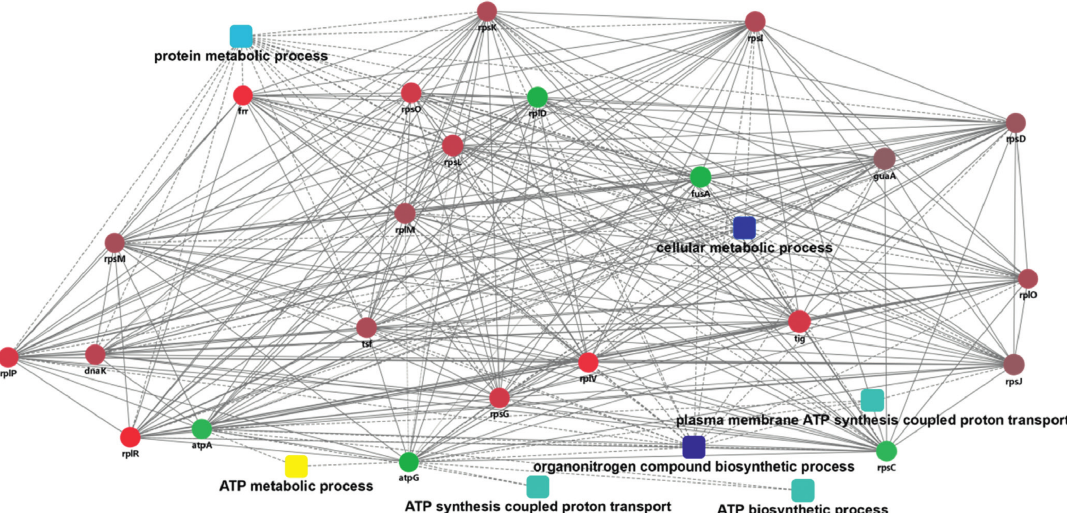
Figure 5: PPI network: significantly upregulated differentially expressed proteins of S. putrefaciens cultivated at 4 ° C and 30 ° C, respectively. The proteins upregulated in S. putrefaciens are colored in a gradient color from white to red, 1.52 ≤ FC ≤ 6.36.